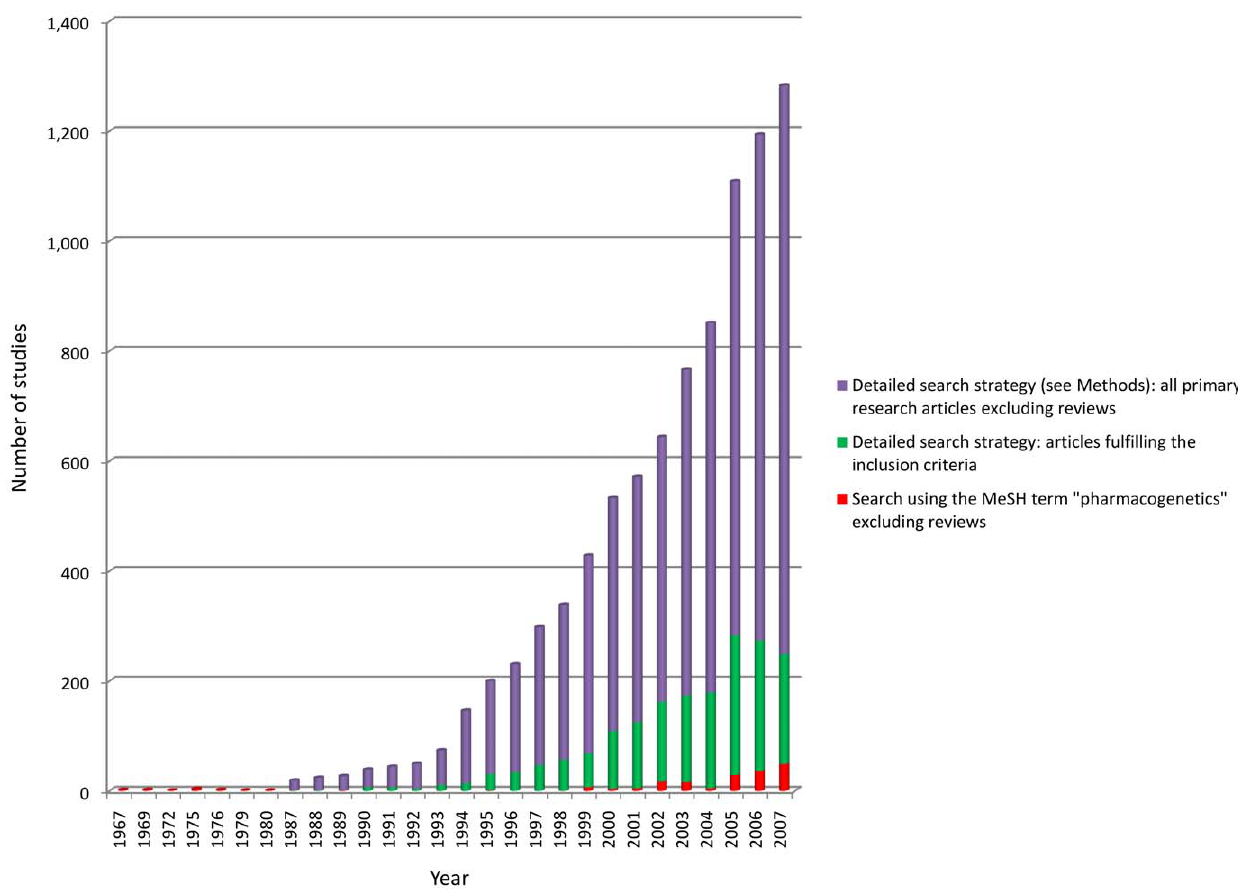
Figure 2. Growth in publications in the field of pharmacogenetics from 1967–2007 (inclusive). Our detailed search strategy incorporating both Medical Subject Headings (MeSH) and free-text terms (filtered for Humans and excluding Reviews/Editorials) identified 6,548 original articles (purple bars) of which 1,668 fulfilled the inclusion criteria (green bars). By contrast the total number of articles obtained based on a search using the MeSH term ‘‘pharmacogenetics’’ (including reviews and editorials) was 4,674, of which only 183 were original articles (red bars), indicating a ratio of approximately 1:25 of original research to commentary/review.